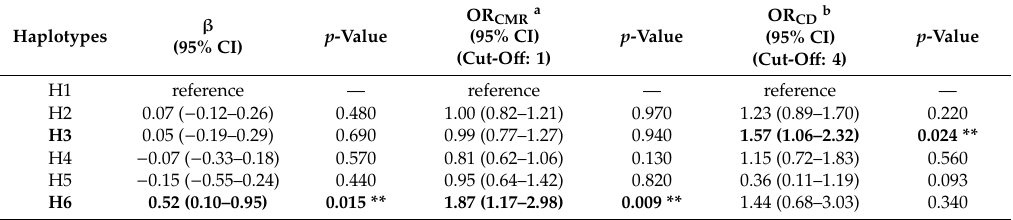
Table 7. The e ff ect of haplotypes in LIPC gene on triglycerides to HDL-C ratio (TG / HDL-C ratio) in combined population (Hungarian Roma and Hungarian general together). The association was evaluated under adjusted models (ethnicity, sex, age, body mass index, systolic and diastolic blood pressure, fasting glucose level, antihypertensive, antidiabetic and lipid-lowering treatment). OR CMR a OR CD b β p -Value p -Value p -Value Haplotypes (95% CI) (95% CI) (95% CI) (Cut-O ff : 1) (Cut-O ff : 4) H1 reference — reference — reference — H2 0.07 ( − 0.12–0.26) 0.480 1.00 (0.82–1.21) 0.970 1.23 (0.89–1.70) 0.220